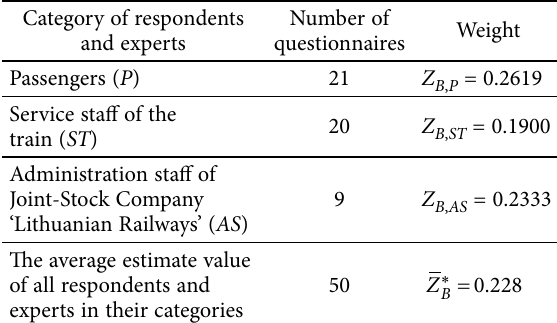
Table 1. The significance (weight) of the criteria of group B describing travel by train Category of respondents and experts